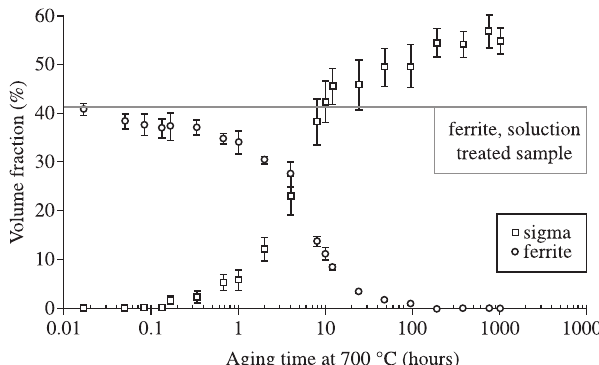
Figure 3. Ferrite and sigma phase content (vol. %) as a function of aging time at 700 °C.